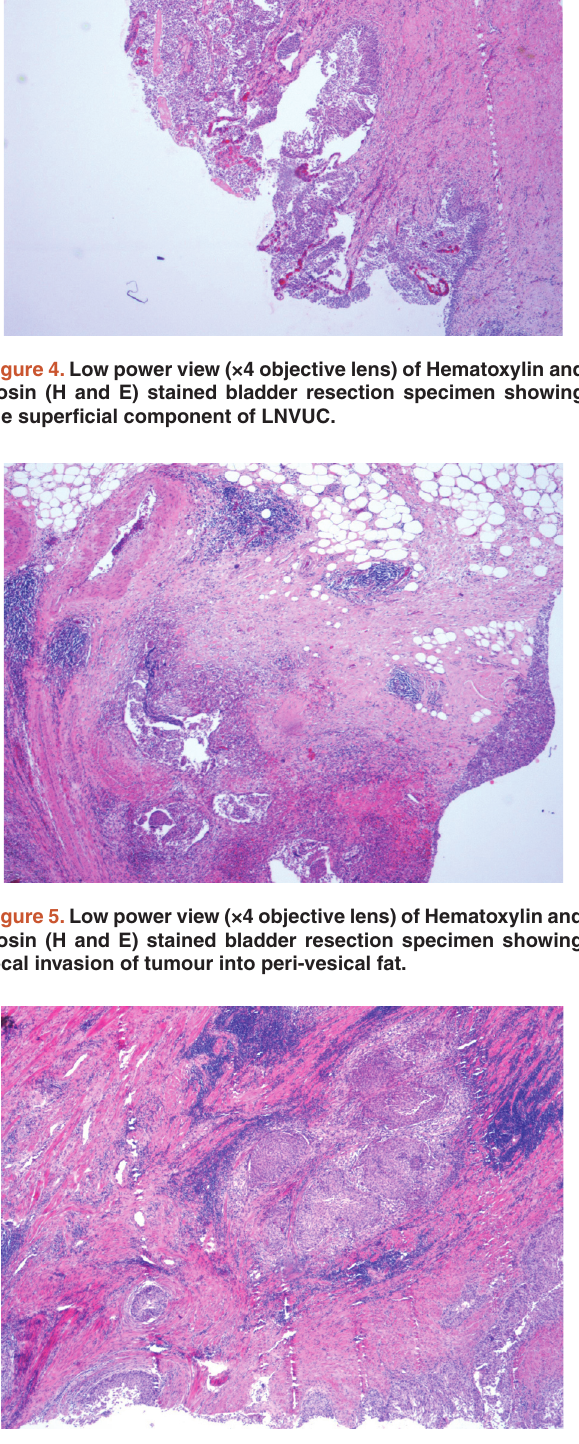
Figure 6. Low power view (×4 objective lens) of Hematoxylin and Eosin (H and E) stained bladder resection specimen showing tumour nests invading prostatic stromal